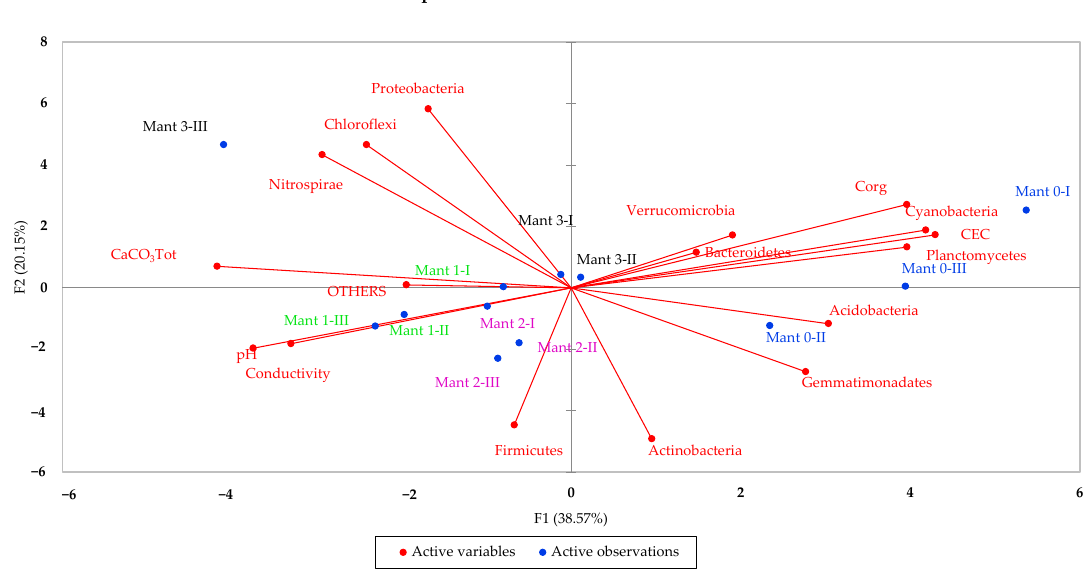
Figure 6. Principal component analysis (PCA) among the microbiological and physicochemical characteristics of soil sample. Abbreviations are as follows: CaCO 3 Tot; total content of carbonate; EC, electrical conductivity; CEC, cation exchange capability; C org , content of organic carbon. Soil samples: Mant 0, control soil (original Vertisol not affected by pedotechnics), while Mant 1, Mant 2 and Mant 3 represent the anthropogenic soils of sites 1 to 3. Depths: I, 0–10 cm; II, 10–30 cm; and III, 30–50 cm.